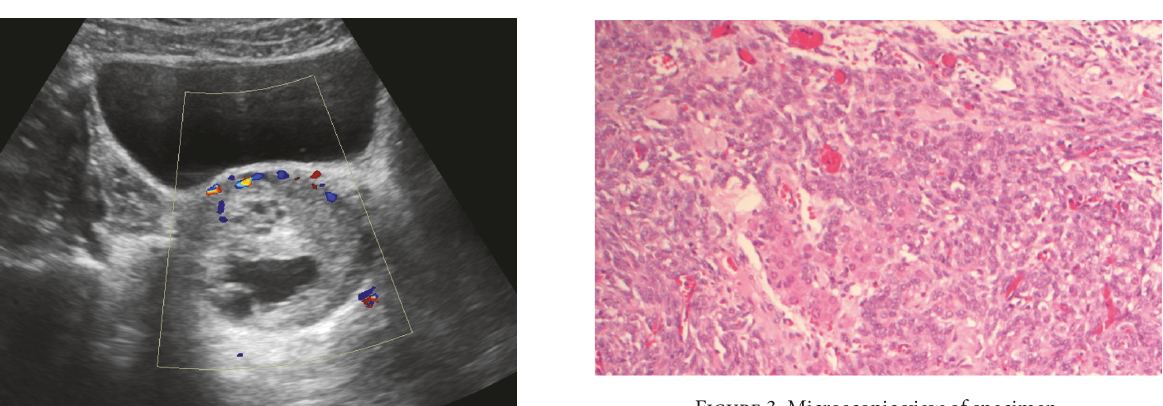
Figure 3: Microscopic view of specimen.